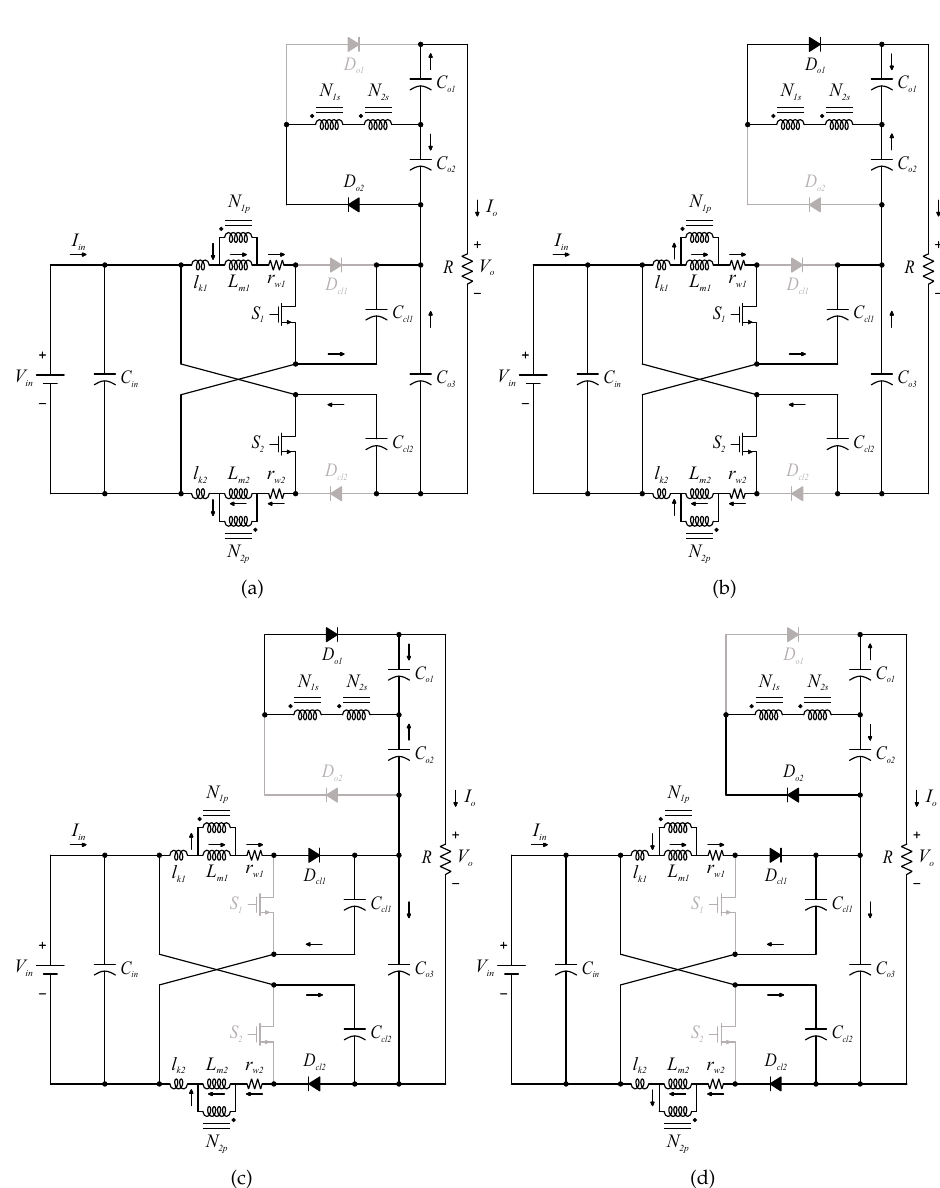
Figure 3. Topological states of the proposed converter. ( a ) State I, ( b ) State II, ( c ) State III, ( d ) State